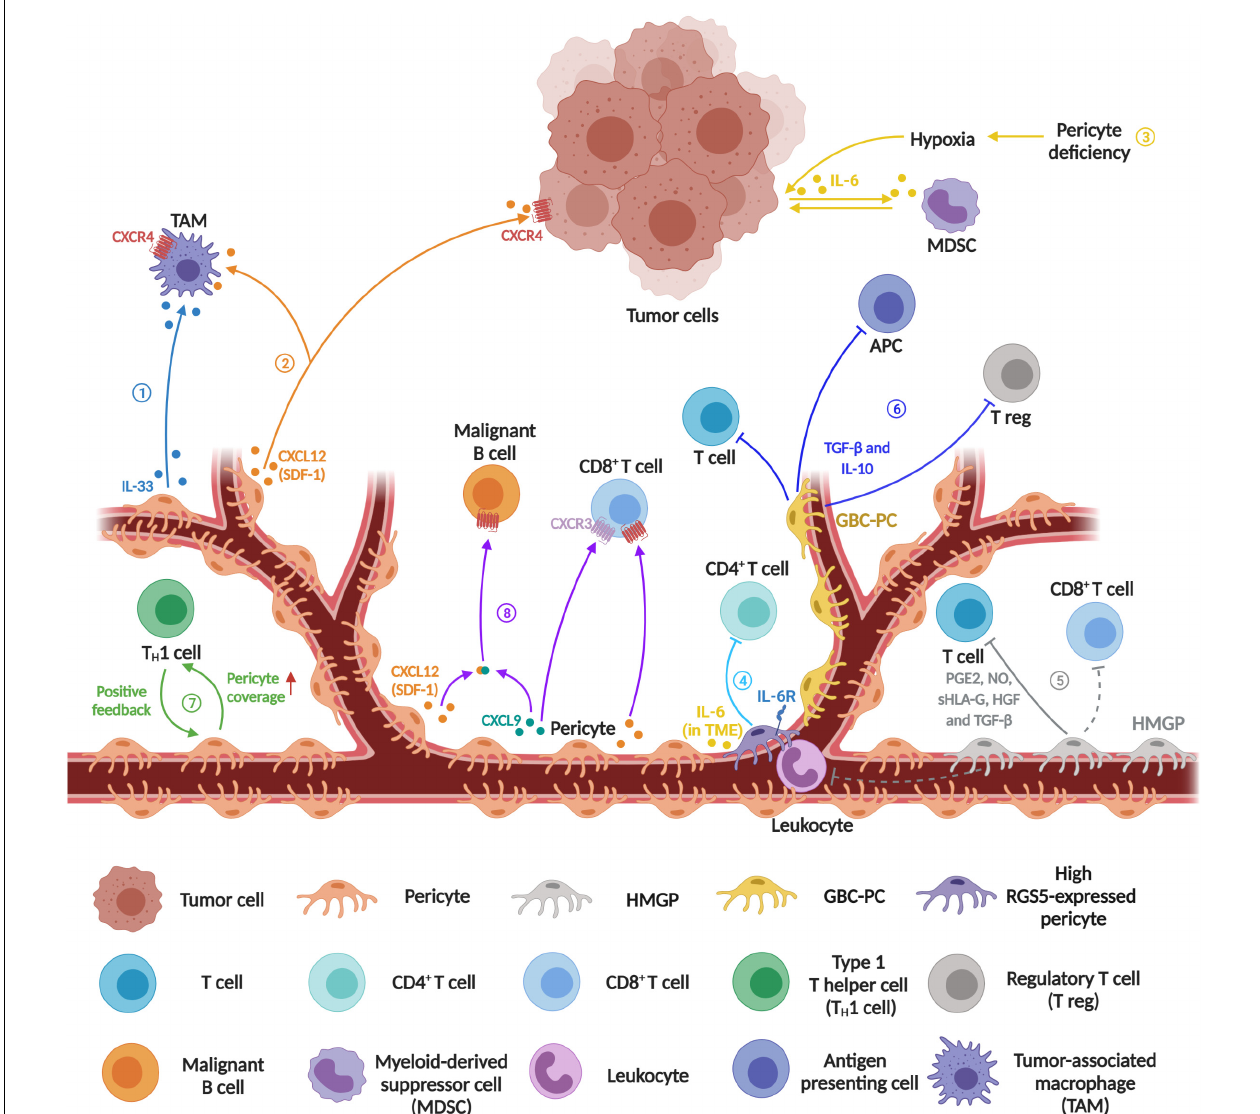
FIGURE 1 | Schematics diagram represents the emerging immunomodulatory role of pericytes in tumor microenvironment. (cid:192) Recruitment of tumor-associated macrophage (TAM). PDGF-BB-stimulated PCs release IL-33 to recruit more TAMs. (cid:193) Increased co-migration of TAMs and tumor cells. PC-derived chemokine CXCL12 (SDF-1) contributes to the co-migration of TAMs and tumor cells during innate immune response. (cid:194) Increased myeloid-derived suppressor cells (MDSCs) transmigration. PC loss causes leaky blood vessels and inadequate oxygen supply leading to tumor hypoxia, which then induces IL-6 expression in tumor cells to increase MDSC transmigration, resulting in suppression of the T cell-mediated anti-tumor response. (cid:195) Induced CD4 + T cell anergy. Tumor PCs act as negative regulators of CD4 + T cell activity. (cid:196) Inhibition of mitogen- and allogeneic-stimulated T cell proliferation. Human malignant glioma-derived pericyte (HMGP) releases PGE2, NO, sHLA-G, HGF, and TDF- β to suppress T cell proliferation, while CD90-positive PCs may function as suppressors of the infiltration of leukocytes and CD8 + T cells in malignant glioma. (cid:197) Inhibition of T cell and antigen presenting cell activity, and increased recruitment of regulatory T cells. Glioblastoma conditioned-pericyte (GBC-PC) not only negatively regulates T cell and antigen presenting cell (APC) but also recruits regulatory T cell (T reg). (cid:198) Regulation of blood vessel normalization and immune cell infiltration. In the positive feedback loop between type 1 T helper (T H 1) and blood vessel normalization, PC coverage has a certain impact on T H 1-mediated immune cell infiltration. (cid:199) Enhanced CD8 + T cell recruitment and malignant B cell migration. Perivascular cell derived CXCL9 and CXCL12 can recruit CD8 + T cell effectors by binding to their corresponding receptor CXCR3 and CXCR4 respectively. Besides, CXCL9 forms a heterocomplex with CXCL12, which then enhances CXCR4-dependent malignant B cell migration to accumulate on the vessel wall (Created with BioRender.com).